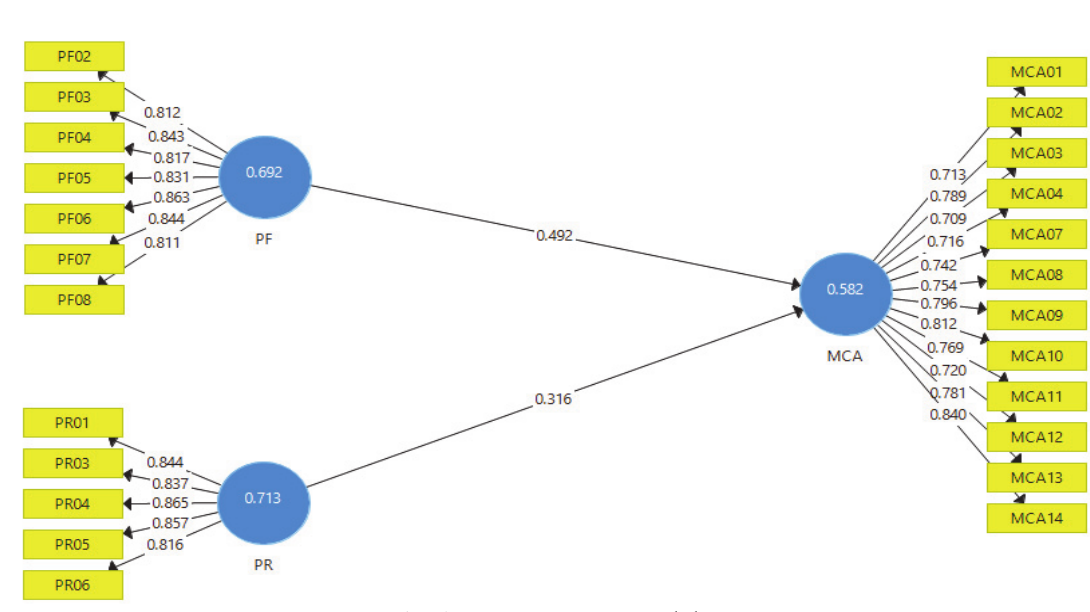
Fig. 2. Measurement